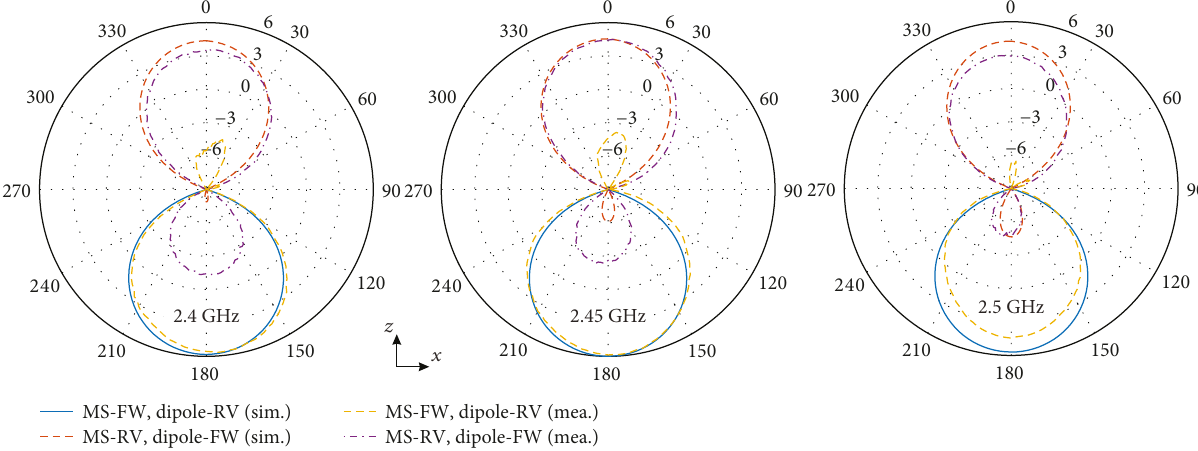
Figure 6: Comparison of radiation patterns (gain) in the x - z planes from simulations and measurement at the frequencies of 2.4, 2.45, and